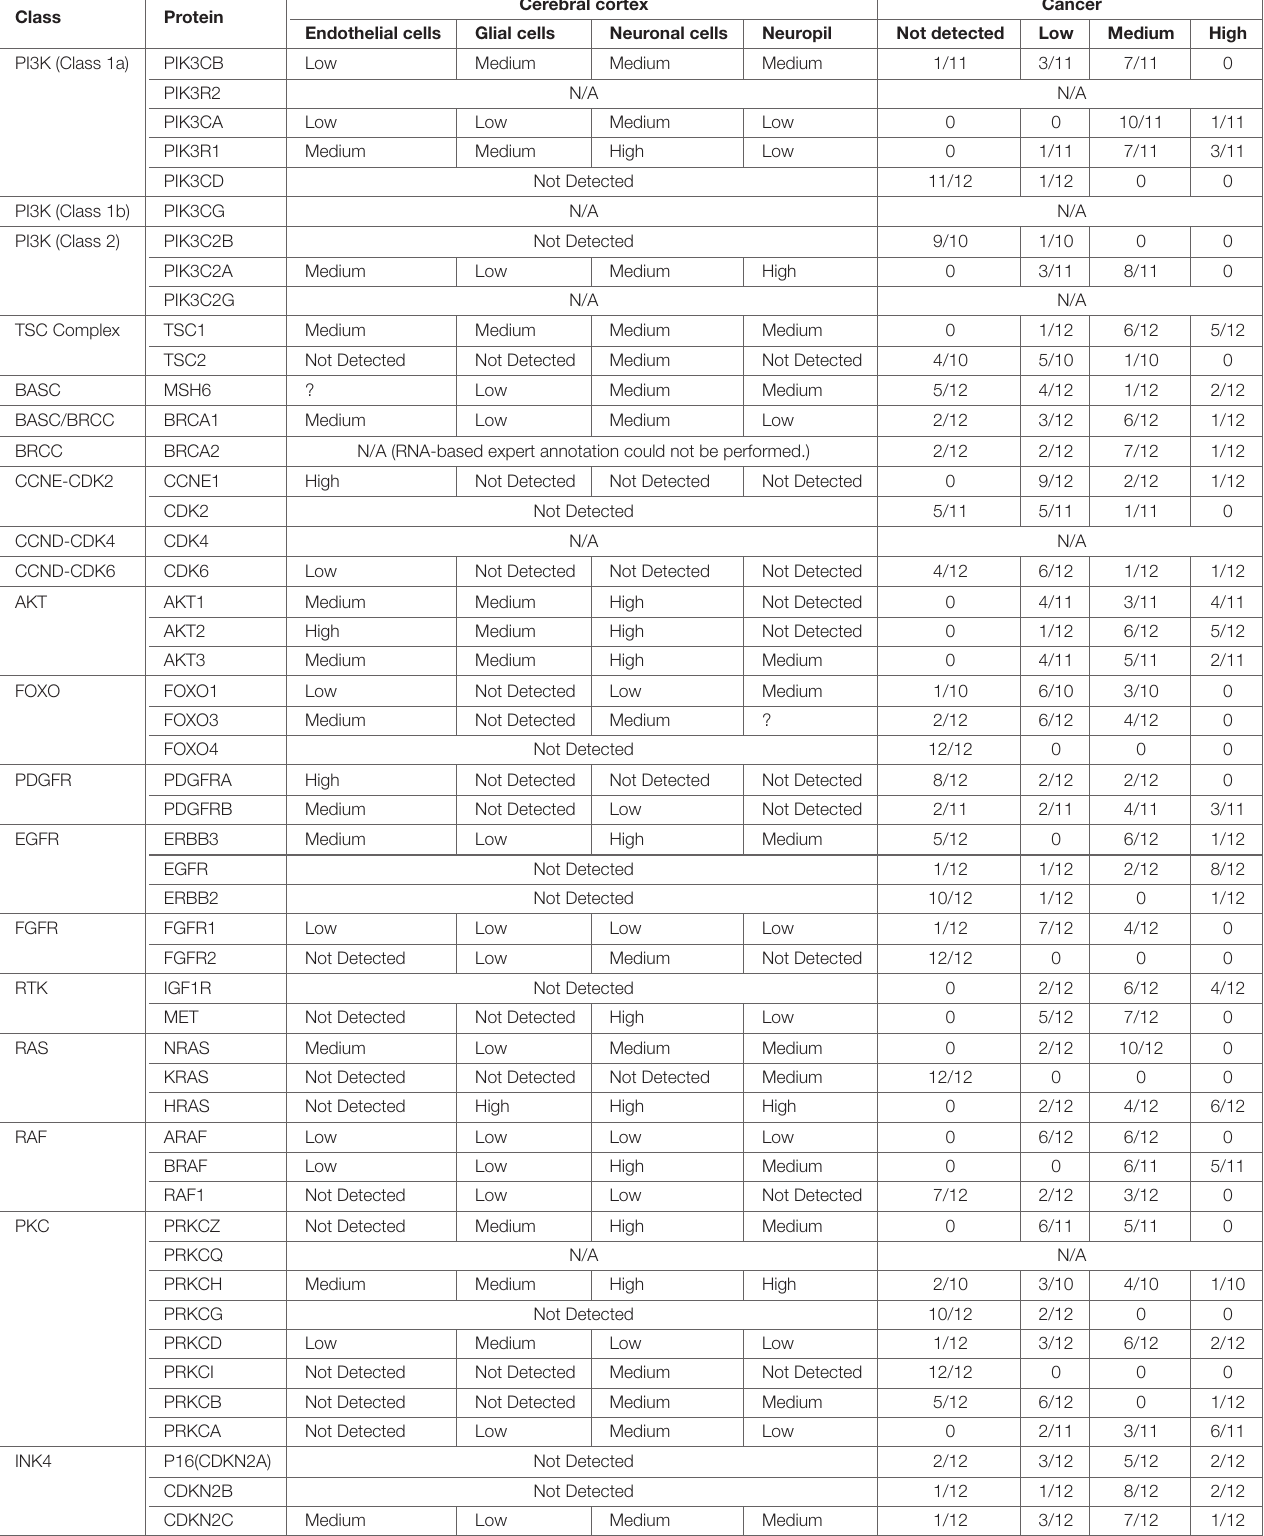
TABLE 1 | Protein classes, names and expression levels in the cerebral cortex and brain tumor which is obtained from www.proteinatlas.org .